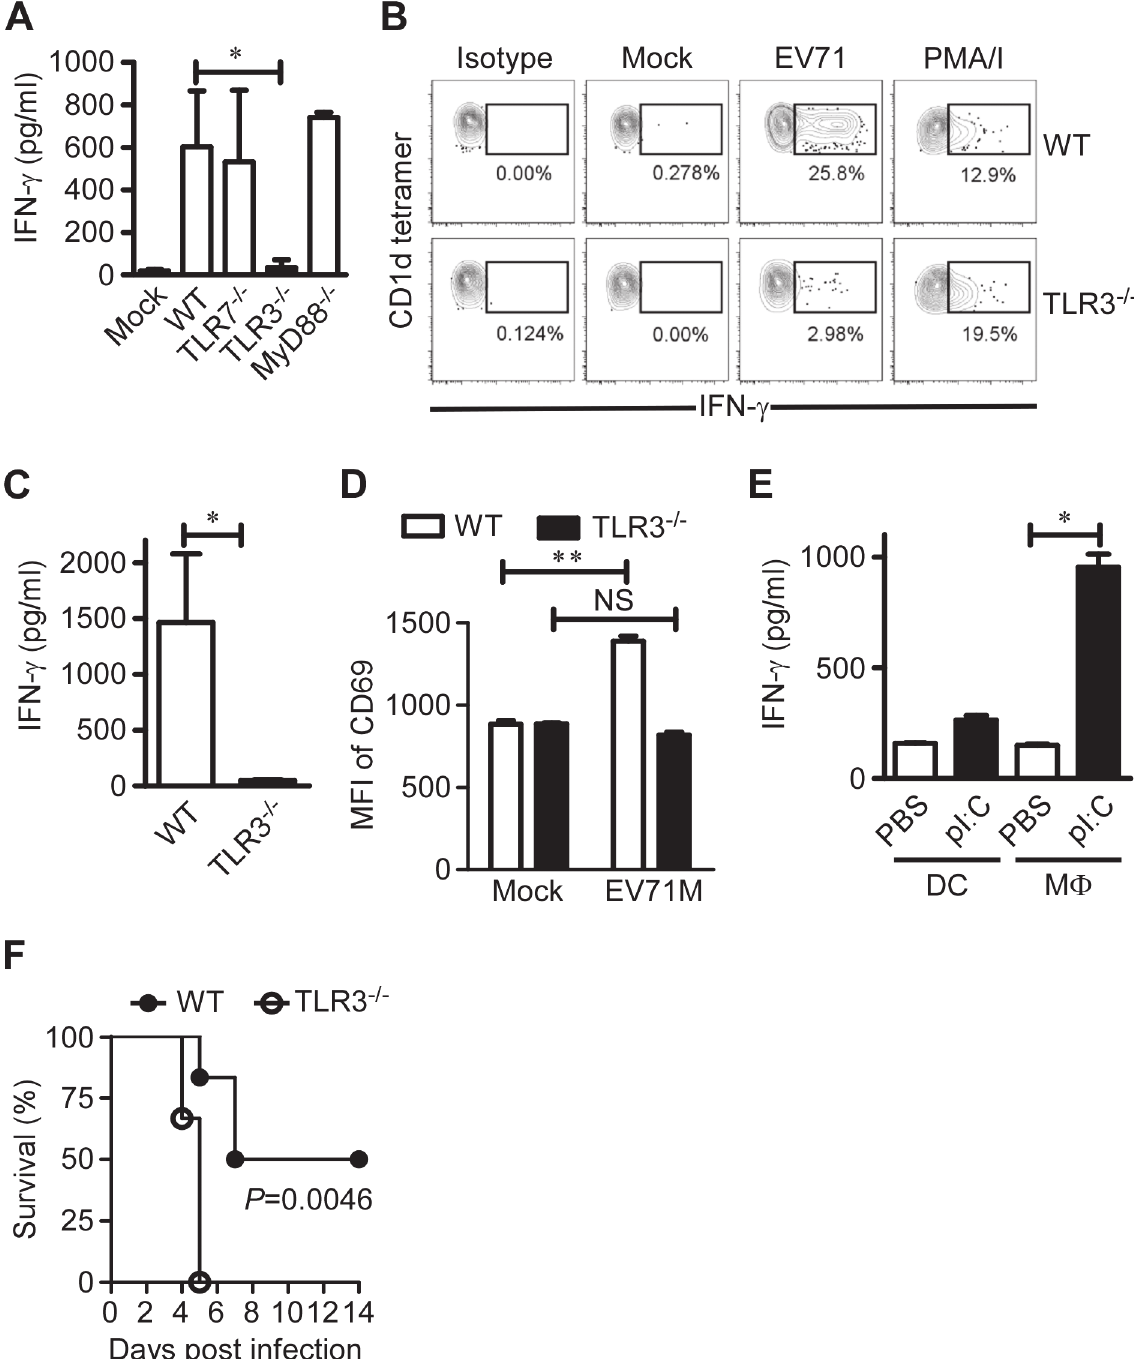
Figure 3. TLR3 is indispensable for iNKT cell activation in EV71 infection. (A) TLR3 signaling is required for IFN- γ production by EV71-infected splenocytes. Splenocytes from WT, TLR3 -/- , TLR7 -/- and MyD88 -/- mice (n = 3 – 5) were cultured with EV71M or mock for 24 hours, and IFN- γ production was quantified by ELISA. (B) TLR3 deficiency dramatically reduced the IFN- γ production of iNKT cells. Splenocytes from CD1d-deficient or WT C57BL/6 mice (n = 3) were infected with EV71M for 24 hours and then stained with TCR β , CD1d tetramer and IFN- γ . Splenocytes were stimulated with PMA and ionomycin (PMA/I) or mock treated (mock), which served as positive and negative controls, respectively. IFN- γ -producing cells are shown among CD1d tetramer + TCR + -gated cells. (C) iNKT cell activation in EV71 infection is dependent on TLR3 signaling. Macrophages from WT or TLR3 -/- mice were cultured in the presence of EV71M for 24 hours. After extensive washing, macrophages were co-cultured for 48 hours with purified iNKT cells from WT mice, and cytokine production was quantified by ELISA. (D) TLR3 signaling is required for in vivo activation of iNKT cells upon EV71M infection. Six-8 week-old WT or TLR3 -/-